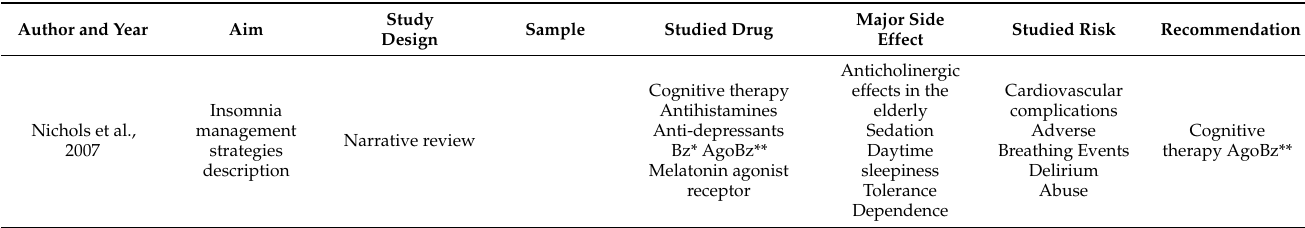
Table 3. Structed summary of